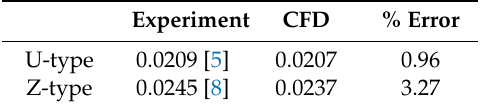
Table 2. Flow uniformity index comparison between experimental data and computational fluid dynamics (CFD)